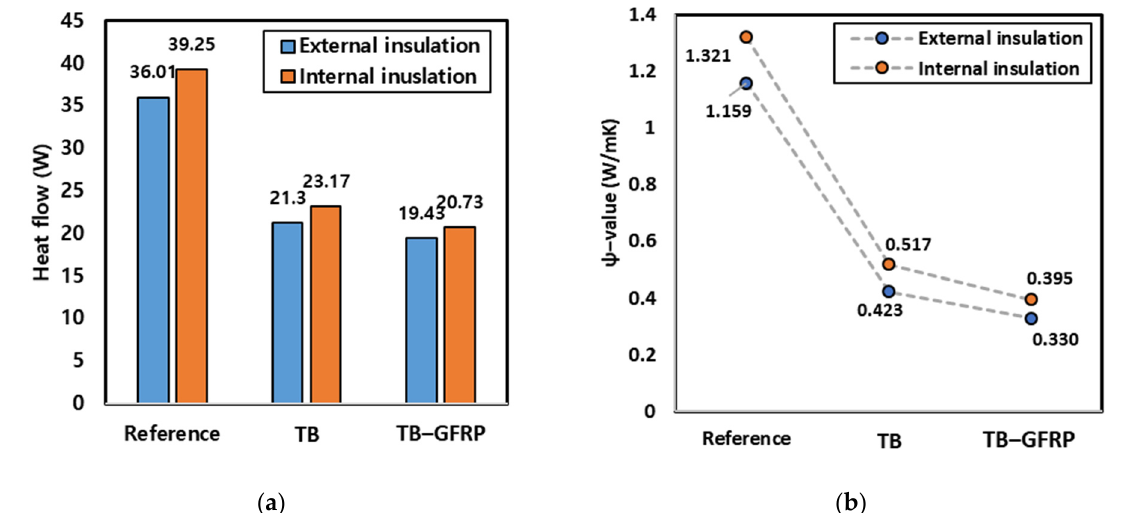
Figure 6. Simulation results under radiant floor heating condition: ( a ) Heat flow through the balcony–slab thermal bridge; ( b ) ψ -value.